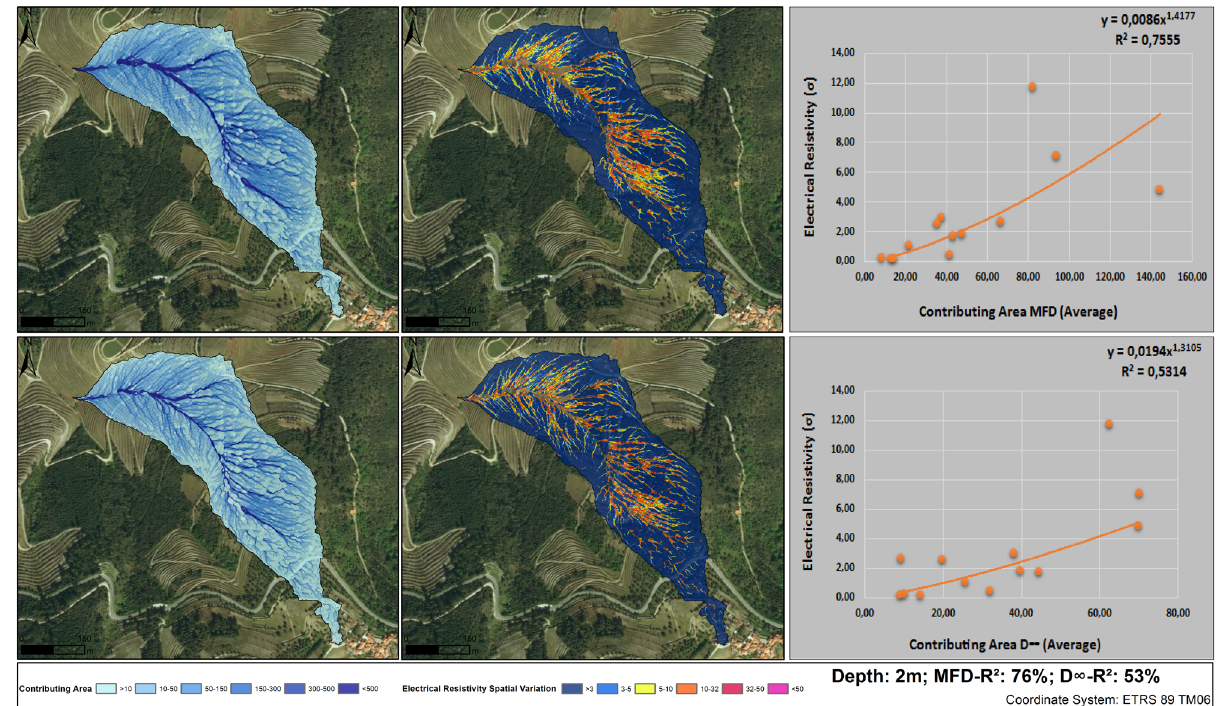
Figure 8: Soil electrical spatial variation at 2 meter of